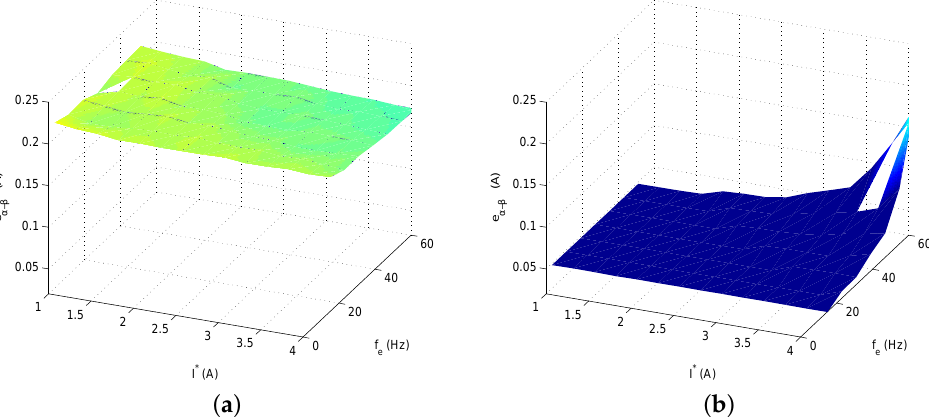
Figure 4. Performance maps for e α − β for the C1 controller, with λ sc = 0.014 ( a ) and with an optimized λ sc ( b